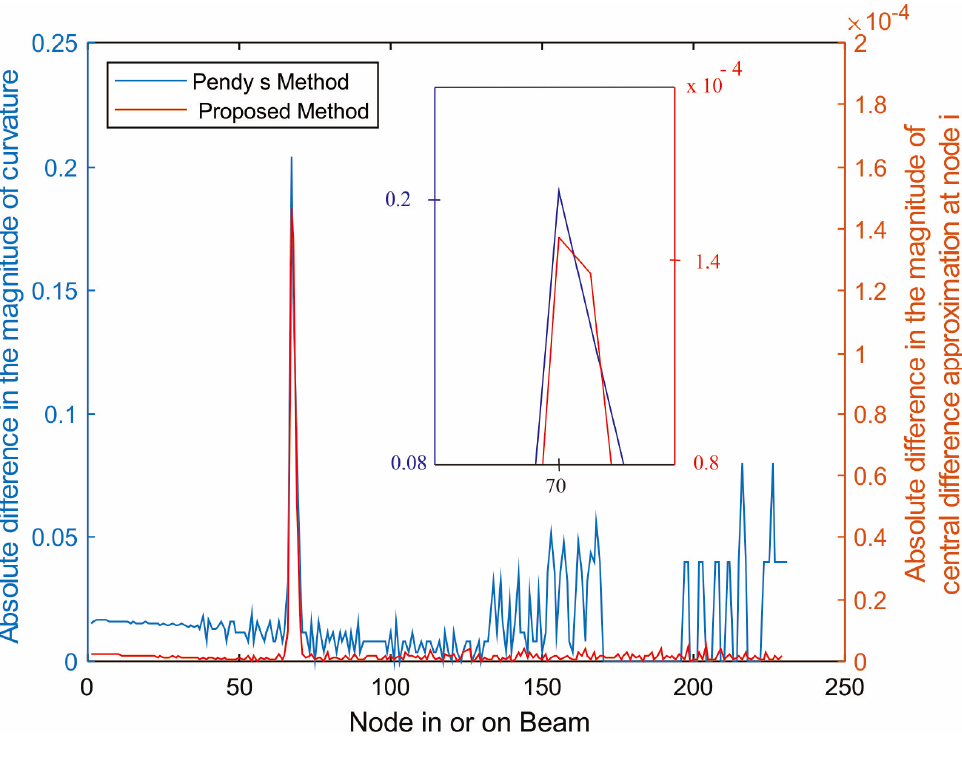
Figure 6. Crack at node 70 (at one-third of beam length).